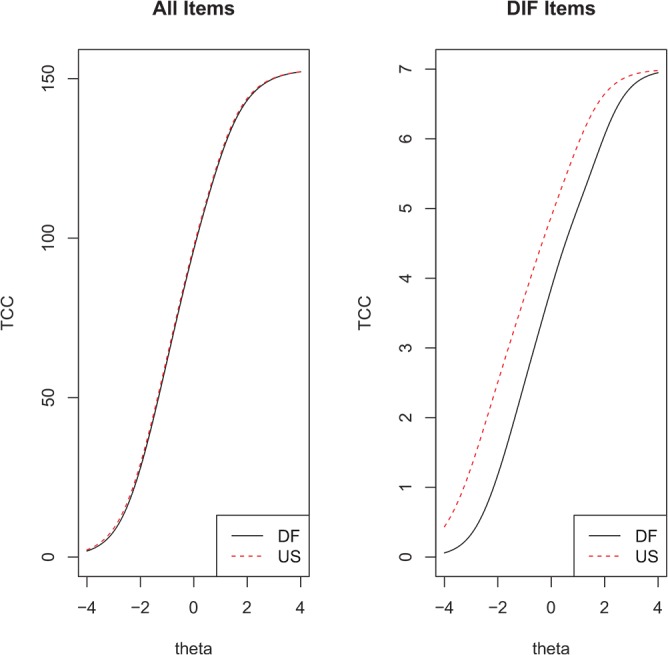
The overall impact of DIF for language on the test characteristic curves (TCC).The TCC shows the relation between the total item scores (y-axis) and theta (x-axis). Left graph shows the TCC for all 40 Dutch-Flemish (DF) and United States (US) PROMIS Pain Interference items (ignoring DIF); the right graph shows the TCC for just the 2 items having DIF.